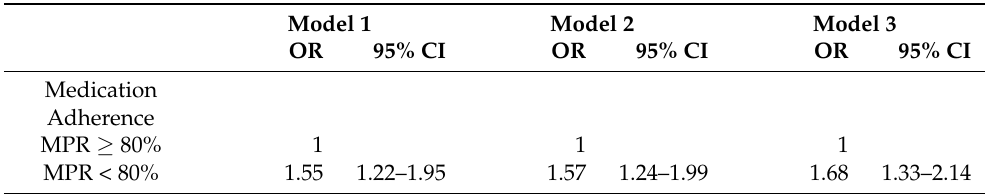
Table 4. Relative risk of acute exacerbation per long-acting inhaler medication adherence in patients with COPD.